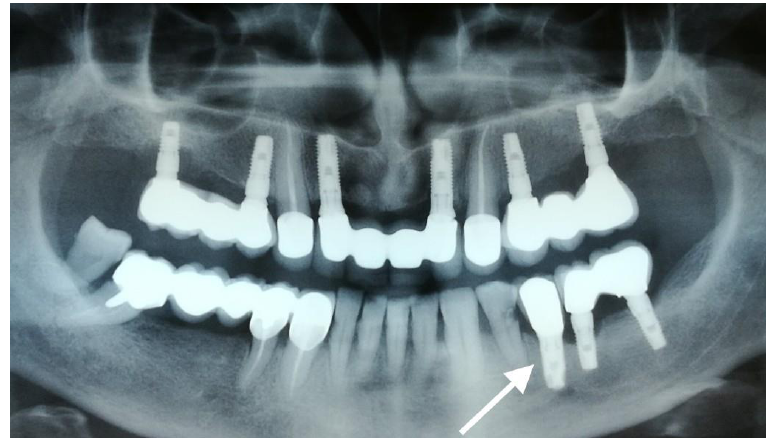
Figure 2. OPG radiography revealing peri-implantitis in quadrants 1, 2, and 3. The implants inserted